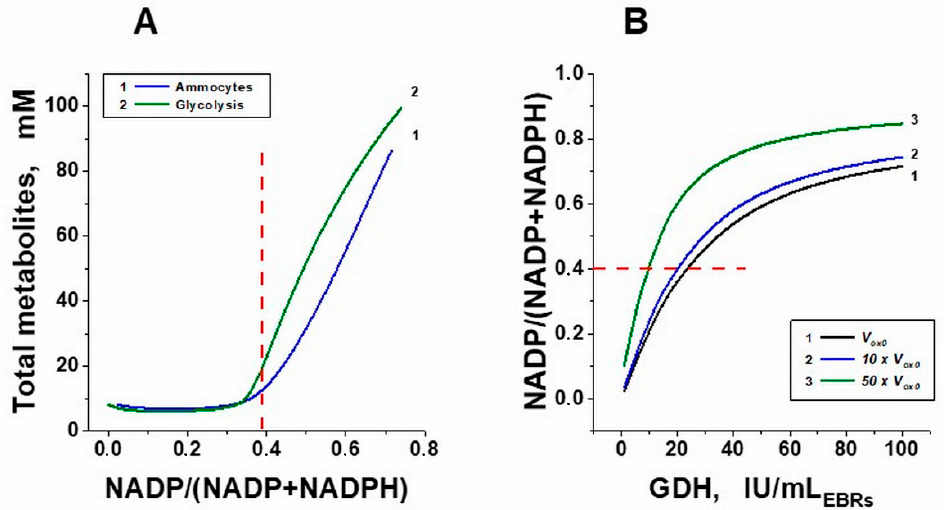
Figure 4. Disappearance of the steady state in glycolysis with an increase in the NADP/(NADP + NADPH) ratio. ( A ) Dependence of the total concentration of all glycolysis metabolites on the stationary value of the NADP/(NADP + NADPH) ratio 500 h after starting the system. Blue curve 1, in an erythrocyte with a built-in ammonium-consuming system; green curve 2, in an erythrocyte without an ammonium-consuming system, but at various established fixed values of stationary NADP concentrations (at d [ NADP ]/ dt = 0). ( B ) Dependence of the stationary value of the NADP/(NADP + NADPH) ratio on encapsulated GDH activity at different total rates of oxidative processes in erythrocytes. The total rate of oxidative processes ( V ox ) corresponds to the physiological state or is increased 10 or 50 times ( V ox 0 , 10 × V ox 0 , and 50 × V ox 0 , respectively). The critical value of the NADP/(NADP + NADPH) ratio above which the steady state in glycolysis disappears is noted in both panels by a red dashed line.